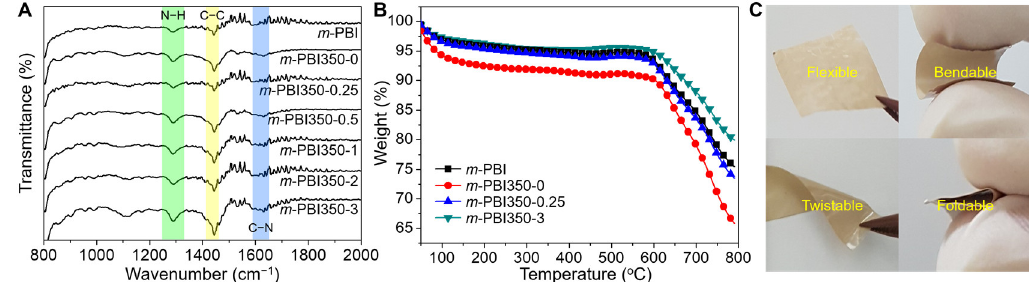
Figure 2. ( A ) Fourier transform infrared spectra and ( B ) thermogravimetric analysis of non-porous m -PBI and m -PBI350-x membranes. ( C ) Demonstration of the robustness of the freestanding m - PBI350-2.